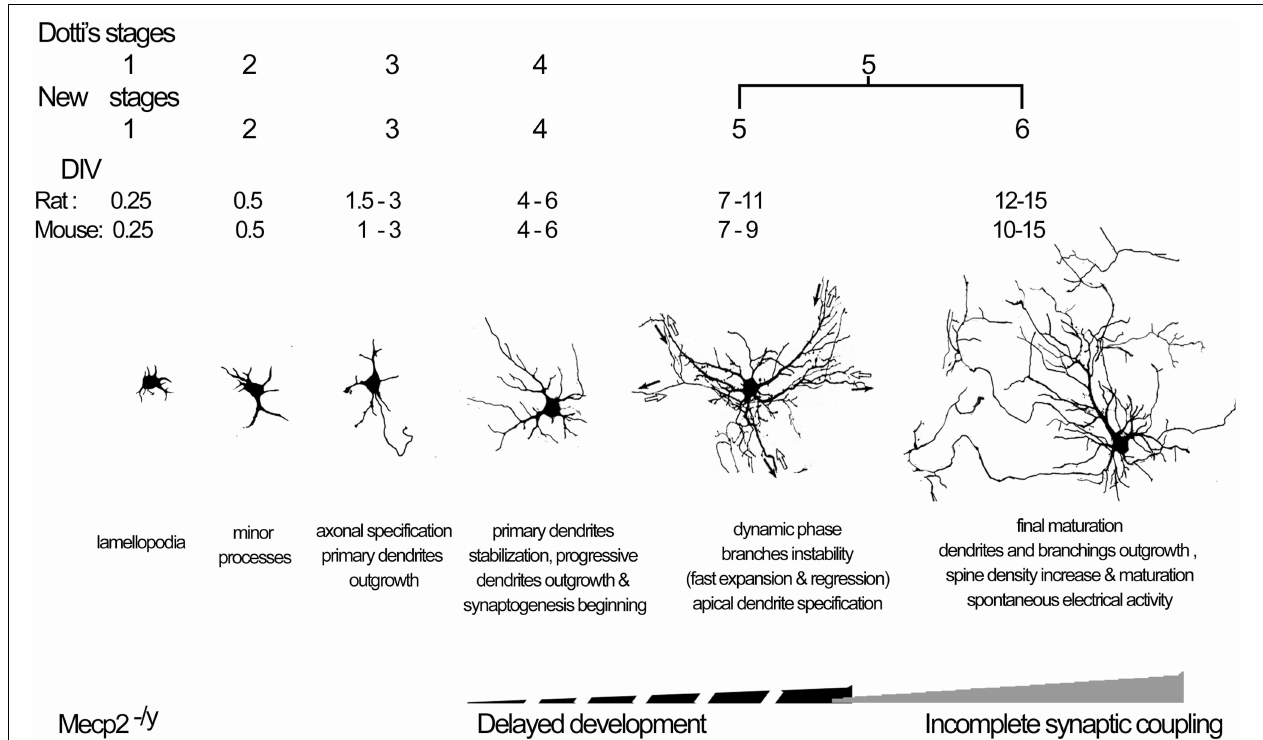
FIGURE 7 | Model of the in vitro neuron staging. Model of the development of rat and mouse hippocampal neurons in vitro , and the timing of developmental and maintenance failure in Mecp2 − / y